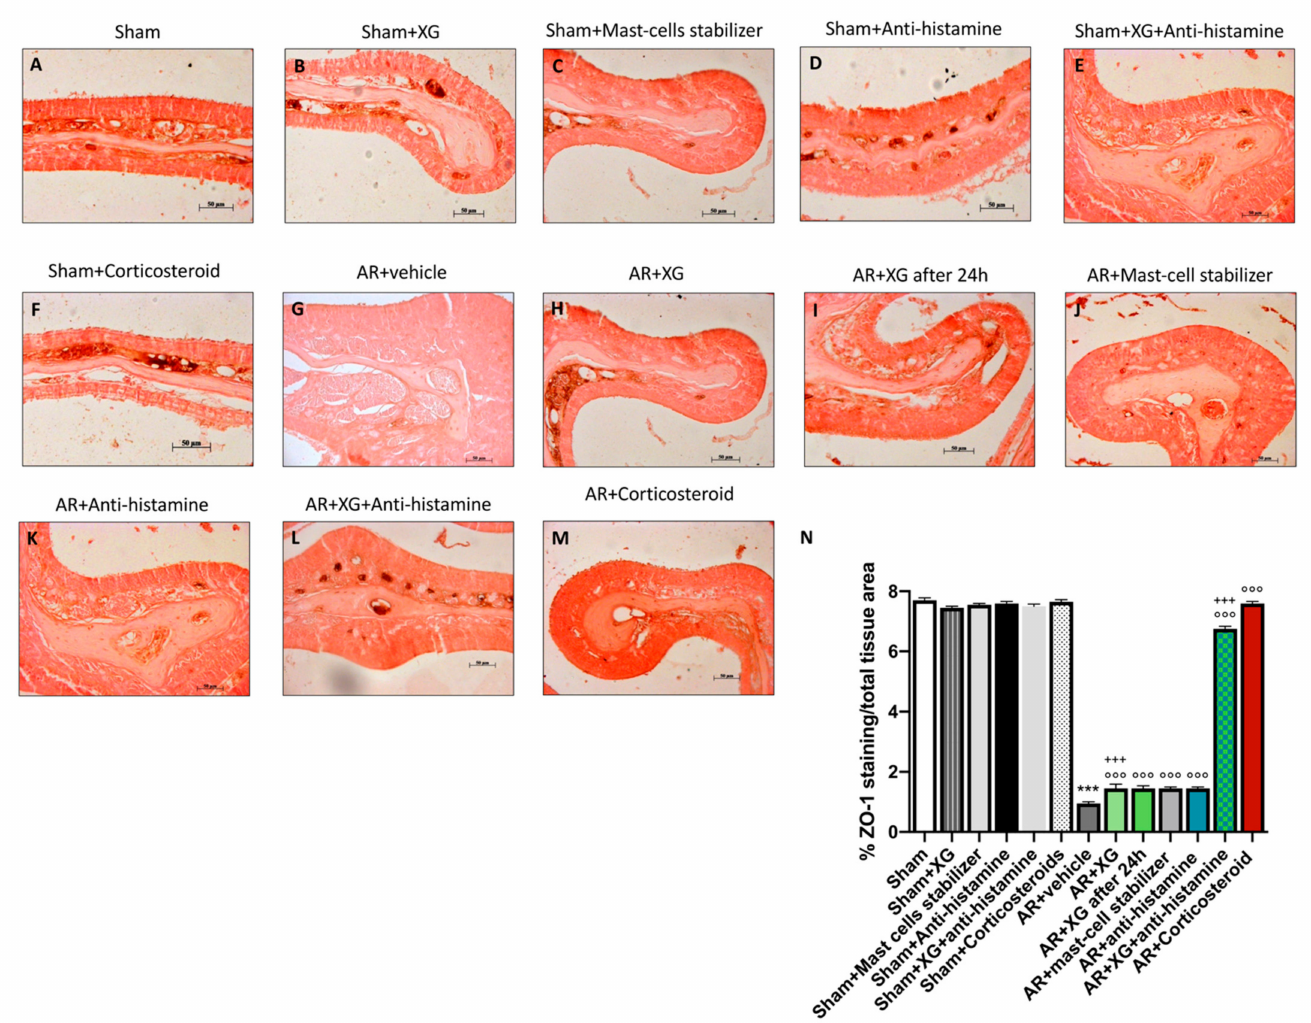
Figure 9. Effect of XG treatment on ZO-1 expression. OVA-sensitized nasal mucosa revealed a marked reduction of ZO-1 expression ( G , histological score N ) compared to the sham animals ( A – F , histological score N ); XG-based spray treatment sig- nificantly preserved ZO-1 expression ( H , I , histological score N ) as well antihistamine ( K , histological score N ) and mast cell stabilizer ( J , histological score N ) administrations. However, a quantitatively more substantial effect was obtained from the co-administration of XG and antihistamine ( L , histological score N ) and corticosteroid treatment ( M , histological score N ). Data are representative of at least three independent experiments. Values are means ± SEM. One-Way ANOVA test. *** p < 0.001 vs. Sham; ◦◦◦ p < 0.001 vs. AR + vehicle; +++ p 0.001 vs. AR +